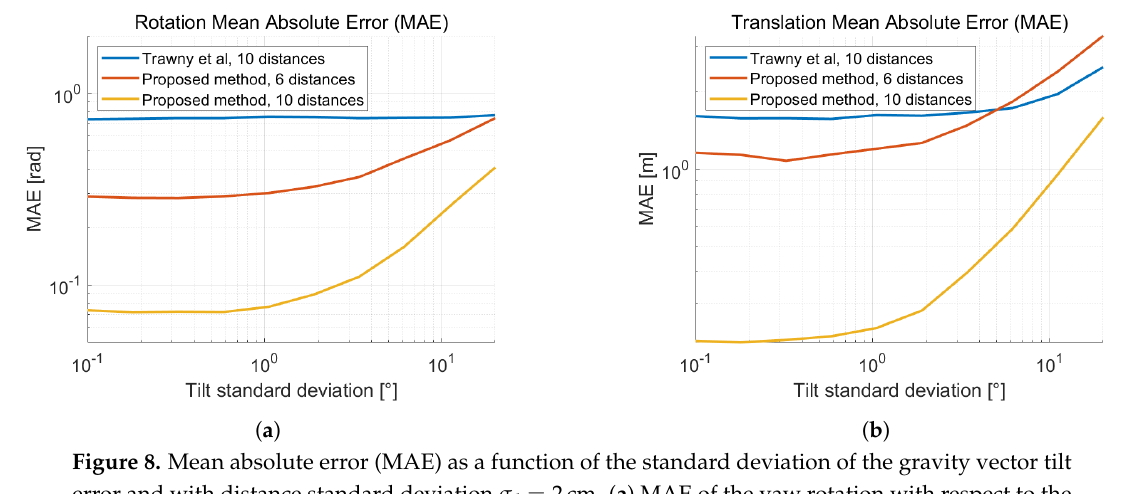
Figure 8. Mean absolute error (MAE) as a function of the standard deviation of the gravity vector tilt error and with distance standard deviation σ d = 2cm. ( a ) MAE of the yaw rotation with respect to the ground truth. ( b ) MAE of the translation with respect to the ground truth.